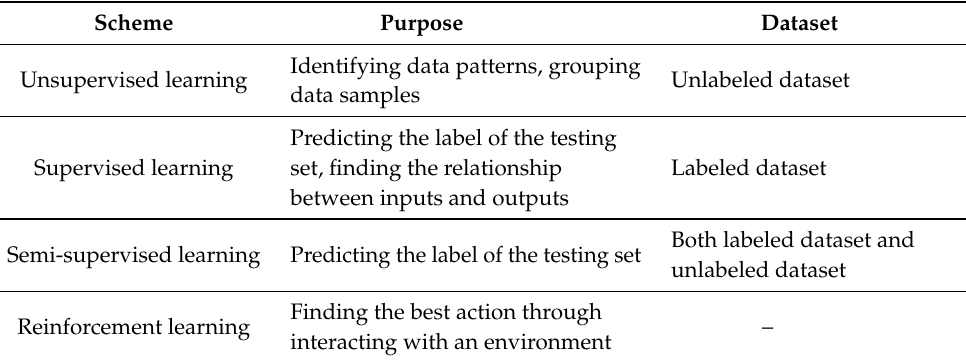
Figure 8. Different learning schemes: ( a ) Unsupervised learning, ( b ) Supervised learning, ( c ) Semi- supervised learning, ( d ) Reinforcement learning. Table 3. Comparison of various learning